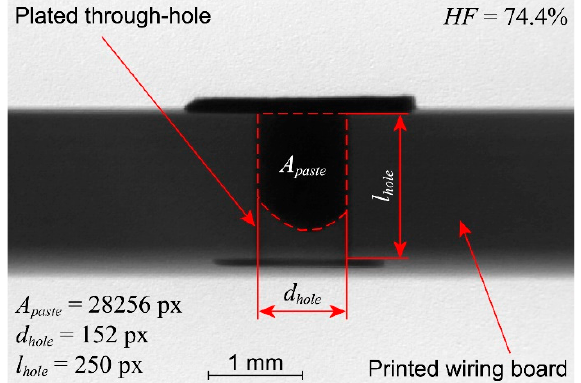
Figure 4. Measuring the hole-filling by the solder paste on a side-view X-ray image; based on comparing the projected area of the solder paste to the projected area of the hole ( d hole · l hole ), the hole-filling is 74.4% in this specific case.